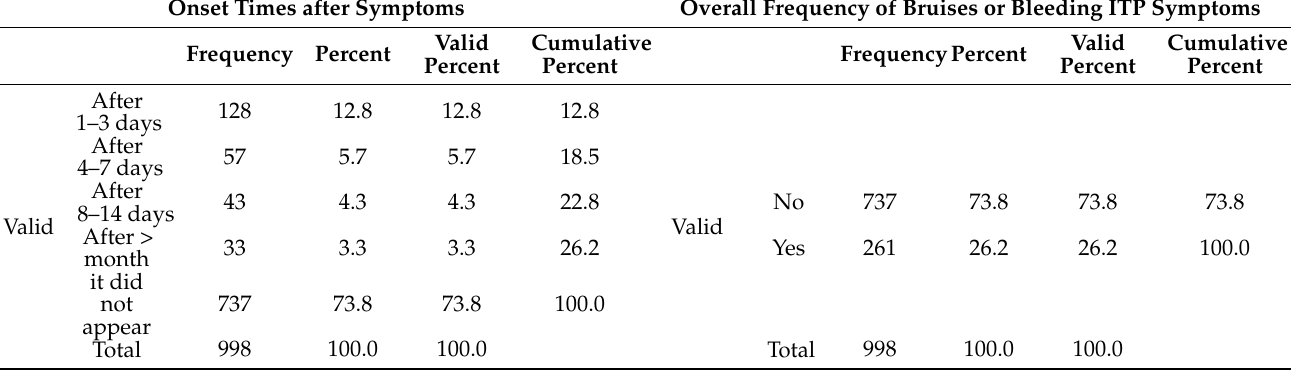
Table 2. Overall frequency of bruises or bleeding ITP symptoms and onset times after any COVID-19 vaccine in Saudi